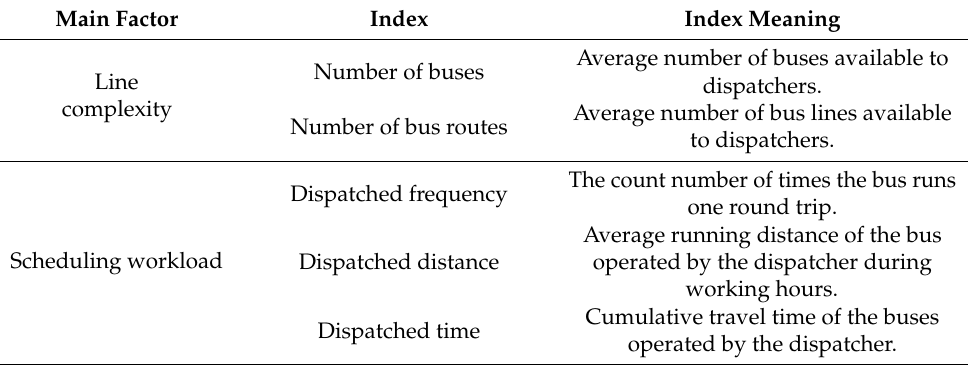
Table 2. Index system of evaluating APTS dispatchers’ scheduling level for urban public